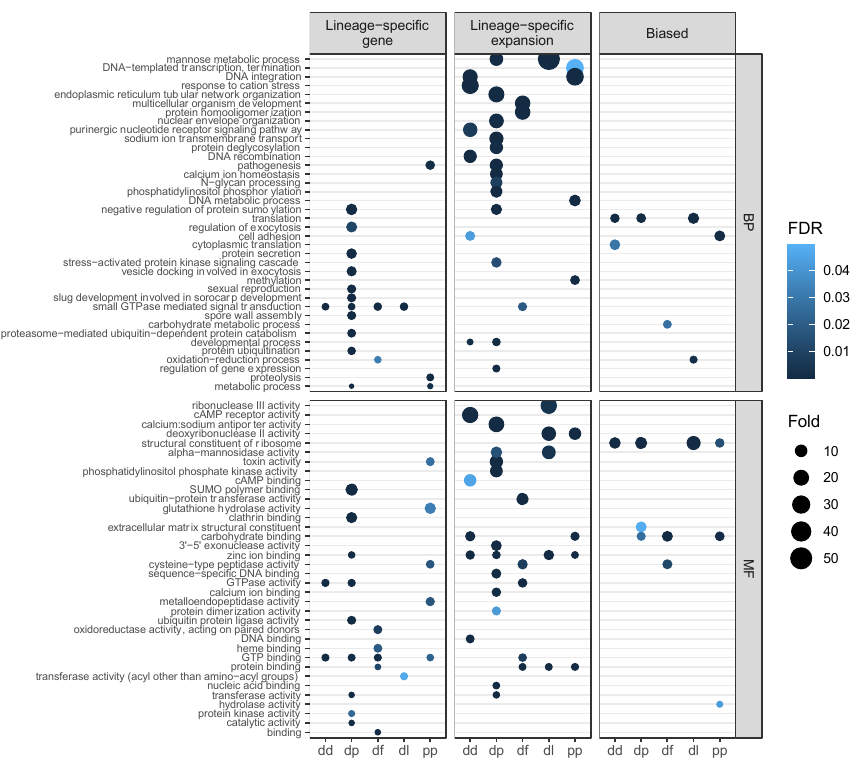
Figure 4. Gene ontology enrichment terms across categories. Dot plot of enriched GO terms across species for lineage-specific genes, lineage-specific expansions, and all biased genes for Biological Processes (BP) and Molecular Functions (MF). The size of the dot represents the fold difference in observed terms versus expected, and the darker the dot the lower the FDR-corrected topGO weighted p -value.